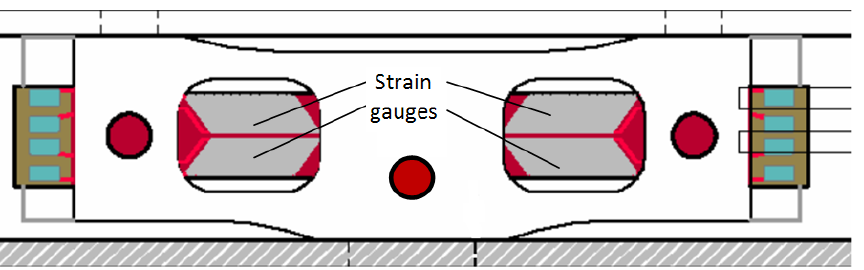
Figure 11. Strain gauge transducer positioning.